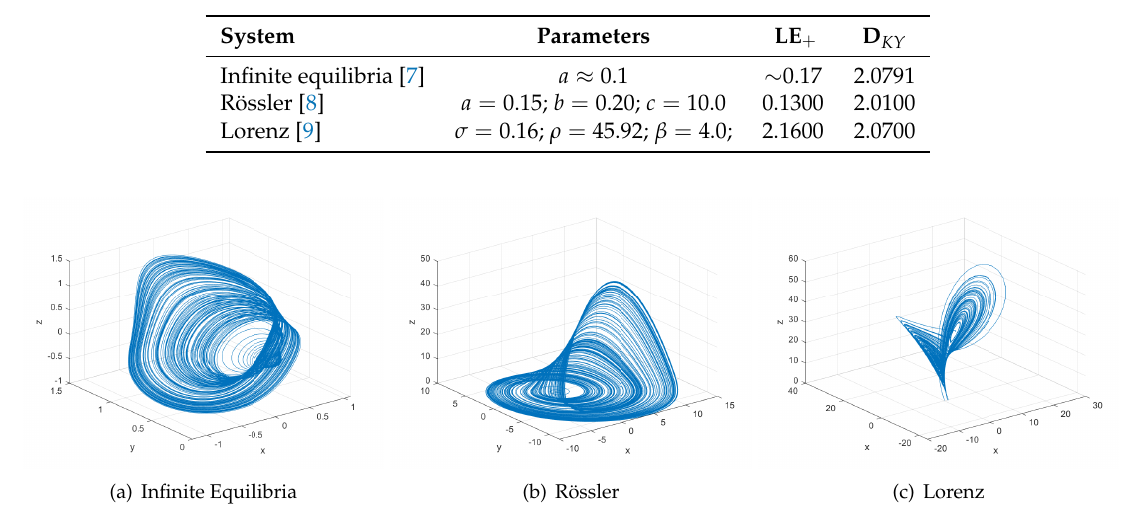
Table 1. LE + and D ky of Equations (1)–(3) reported in the literature.